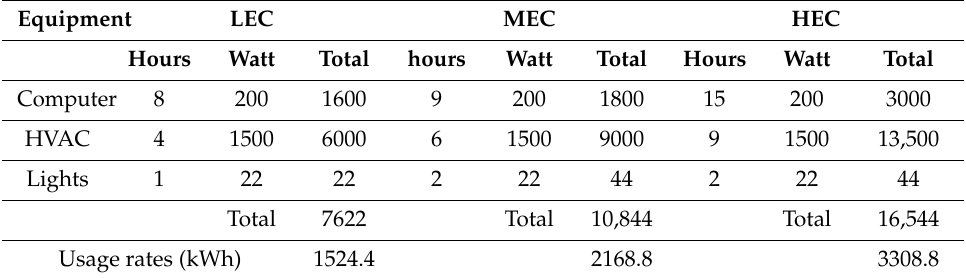
Table 9. Behavior-wise energy usage.